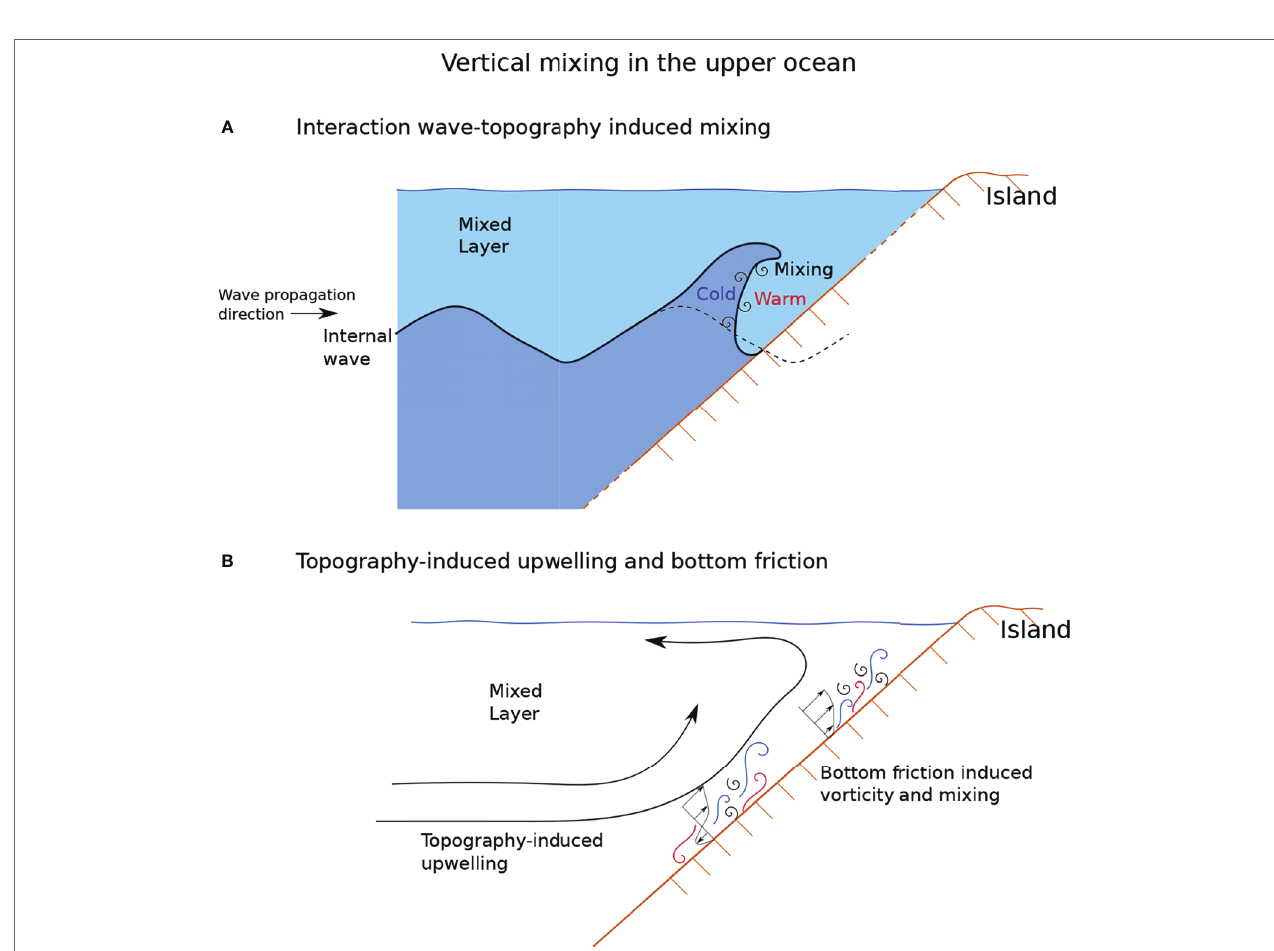
FIGURE 10 | Sketch representing the interactions between ocean dynamics and continental slope which generate ocean mixing: (A) an internal wave propagating towards the continental slope becomes steeper and eventually breaks, generating vertical mixing; (B) simple sketch of a topography-induced upwelling and bottom friction-induced mixing and